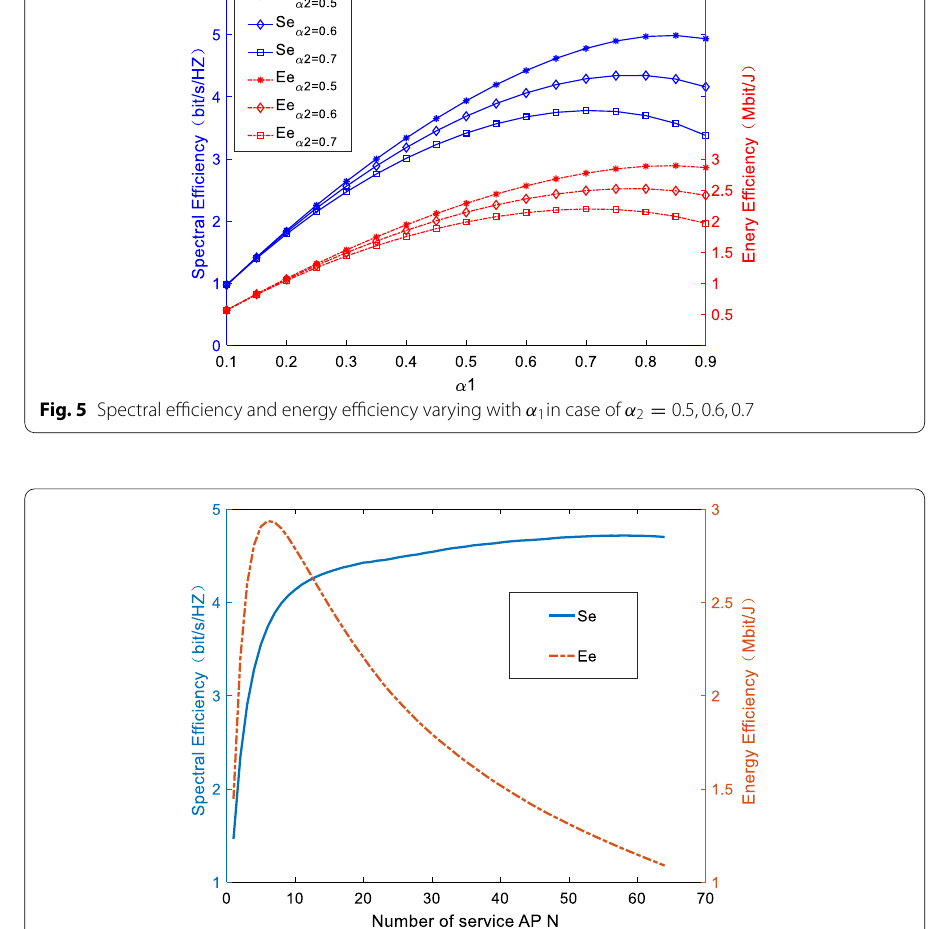
Fig. 6 Schematic diagram of system spectral efficiency and energy efficiency varying with the number of serving